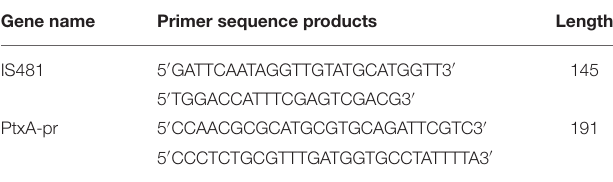
TABLE 1 | Gene primer sequence and product length detected by real-time